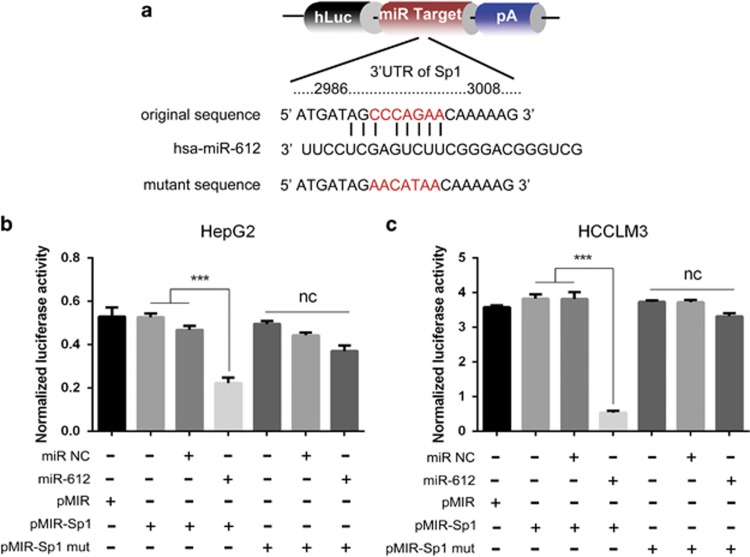
Direct regulation of miR-612 on Sp1 expression. (a) Schematic diagram of the dual luciferase miRNA target reporter vector. (b and c) Luciferase activity was assayed in miR-612-i HepG2 cells and miR-612-o HCCLM3 cells. Data are mean±S.D. (n=3) and are representative of three independent experiments. Statistical analysis by Student's t-test (***P<0.001)